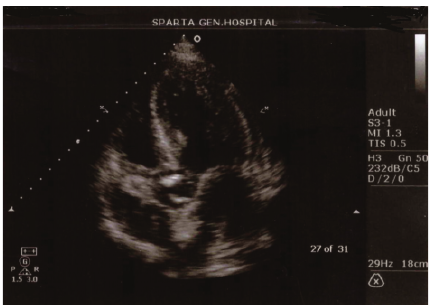
Figure 1: Transthoracic echocardiogram of the patient showing bicuspid aortic valve with